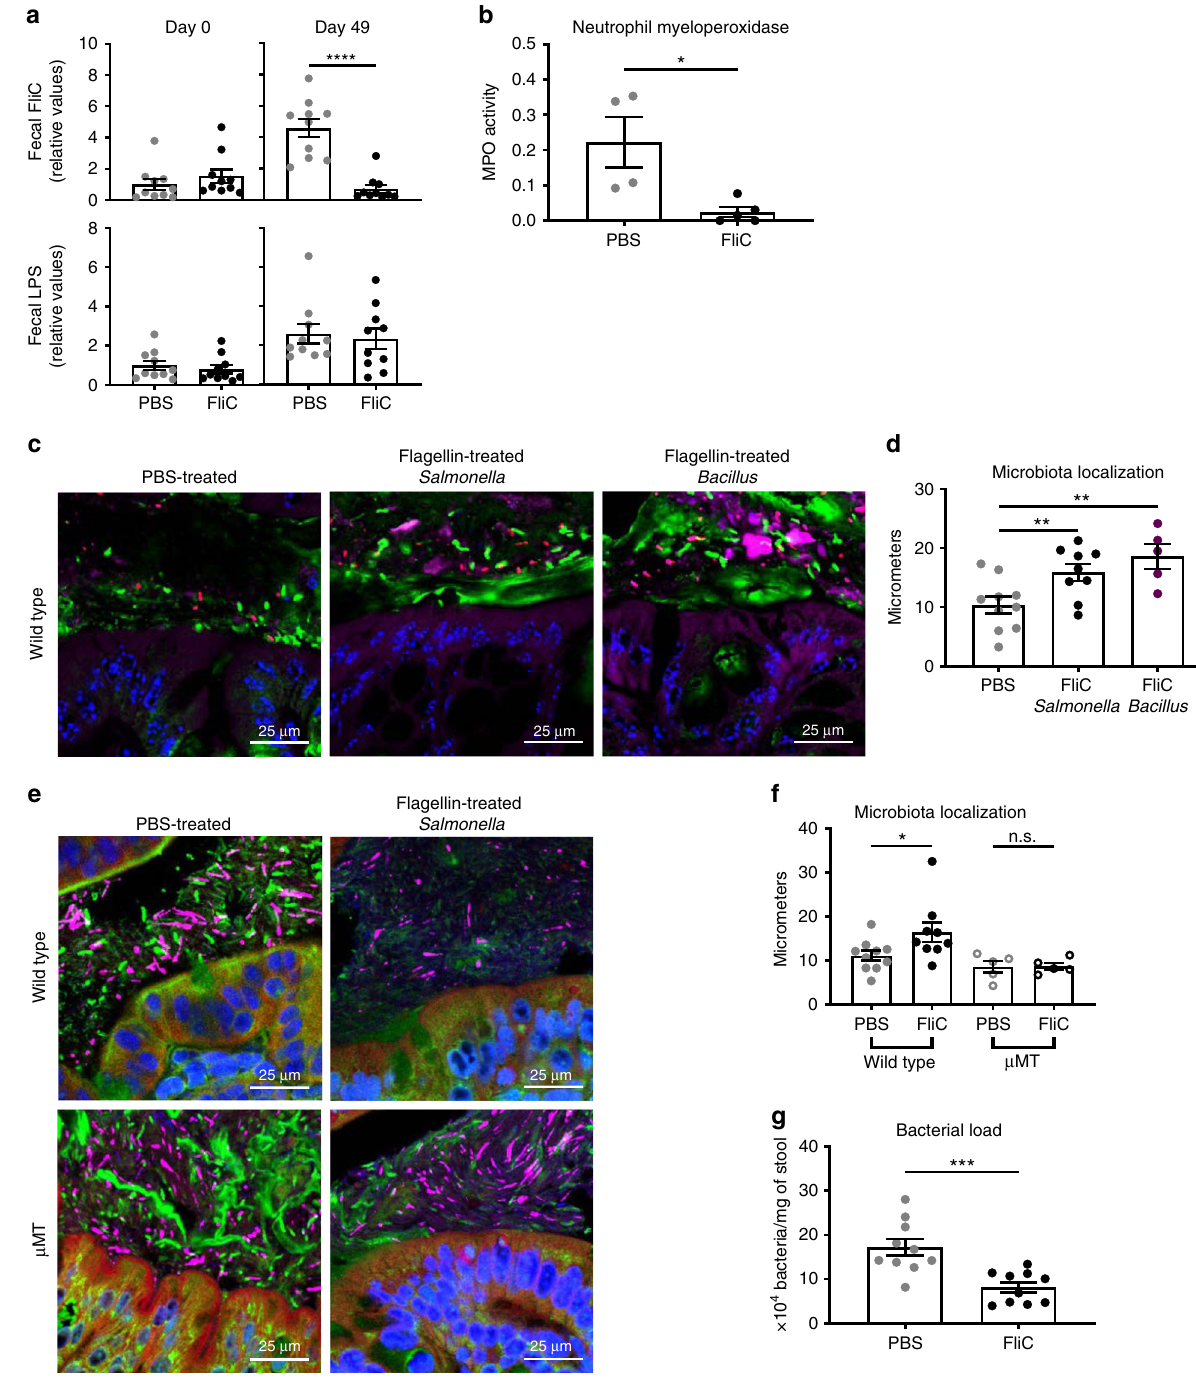
Fig. 3 Flagellin administration alters the intestinal microbiota toward a lower pro-in fl ammatory state. a Fecal pro-in fl ammatory potential was analyzed using HEK 293 cells expressing mTLR5 or mTLR4 measuring bioactive fl agellin and lipopolysaccharide, respectively. b Colonic myeloperoxidase quanti fi cation of 4-week old, wild-type C57BL/6J mice after receiving either vehicle or 10 μ g of fl agellin by intraperitoneal injections weekly for 9 weeks. c – f Colonic microbiota localization analysis of wild type and μ MT mice treated with PBS, Salmonella -derived fl agellin, or Bacillus -derived fl agellin. c , e Confocal microscopy analysis of colonic microbiota localization; Muc2 (green), actin (purple), bacteria (red), and DNA (blue). d , f Distances of closest bacteria to colonic intestinal epithelial cells (IEC) per condition over 2 – 3 high-powered fi elds per mouse. g Fecal bacterial load determined by qPCR analysis of 16 S bacterial DNA in the fecal contents of mice treated with PBS or fl agellin. Data are the means ±S.E.M. Signi fi cance was determined using t test (* p ≤ 0.05 ** p ≤ 0.01 *** p ≤ 0.001 **** p ≤ 0.0001, n.s. indicates non-signi fi cant). ( N = 4 – 5 mice from one out of three representative experiment). Source data are provided as a Source Data fi